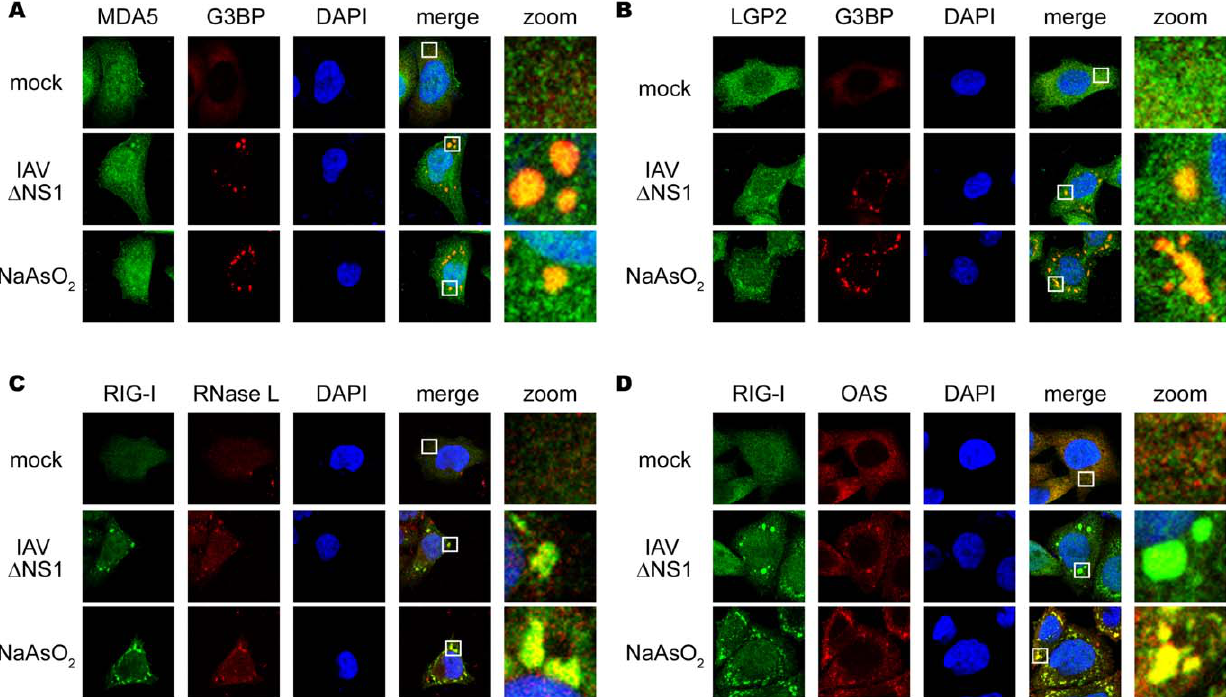
Figure 2. Antiviral proteins are colocalized with SGs. ( A–D ) HeLa cells were mock-treated (mock), infected with IAVA¨NS1 for 9 h, or treated with NaAsO 2 for 1 h. Cells were fixed and stained for G3BP and MDA5 (94.2% colocalization) ( A ), G3BP and LGP2 (97.6% colocalization) ( B ), RIG-I and RNase L (84.5% colocalization) ( C ), RIG-I and OAS (87.4% colocalization) ( D ) in IAVA¨NS1-infected cells. The zoomed images correspond to the boxed regions.